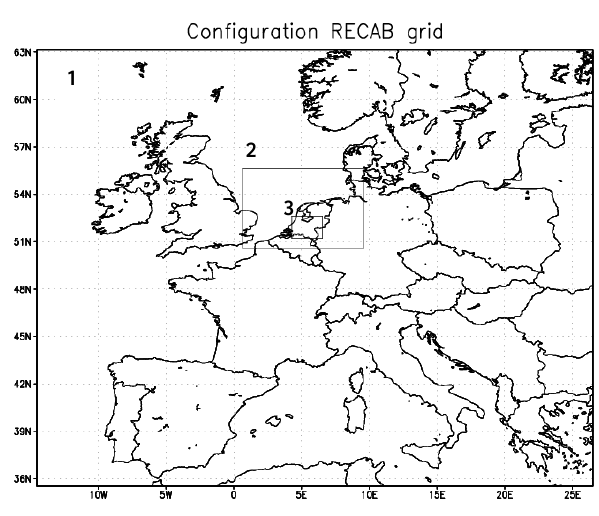
Fig. 2. Configuration of the modelling domain. Boxes and numbers illustrate the three nested